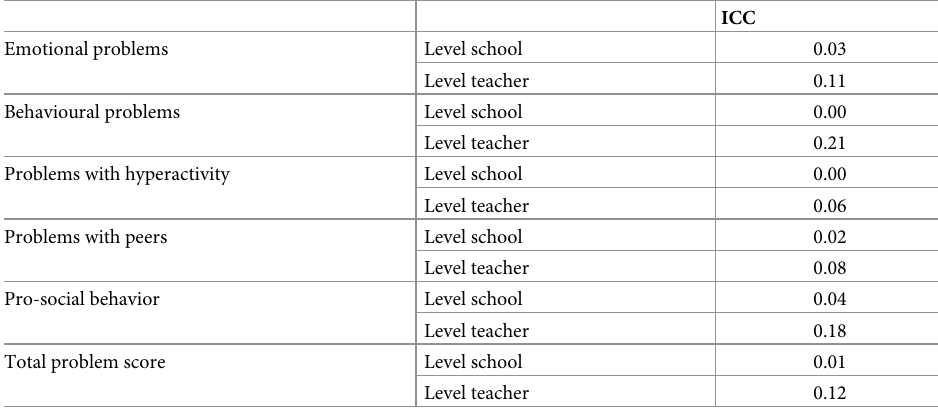
Table 2. Intraclass correlation coefficients for school and teacher